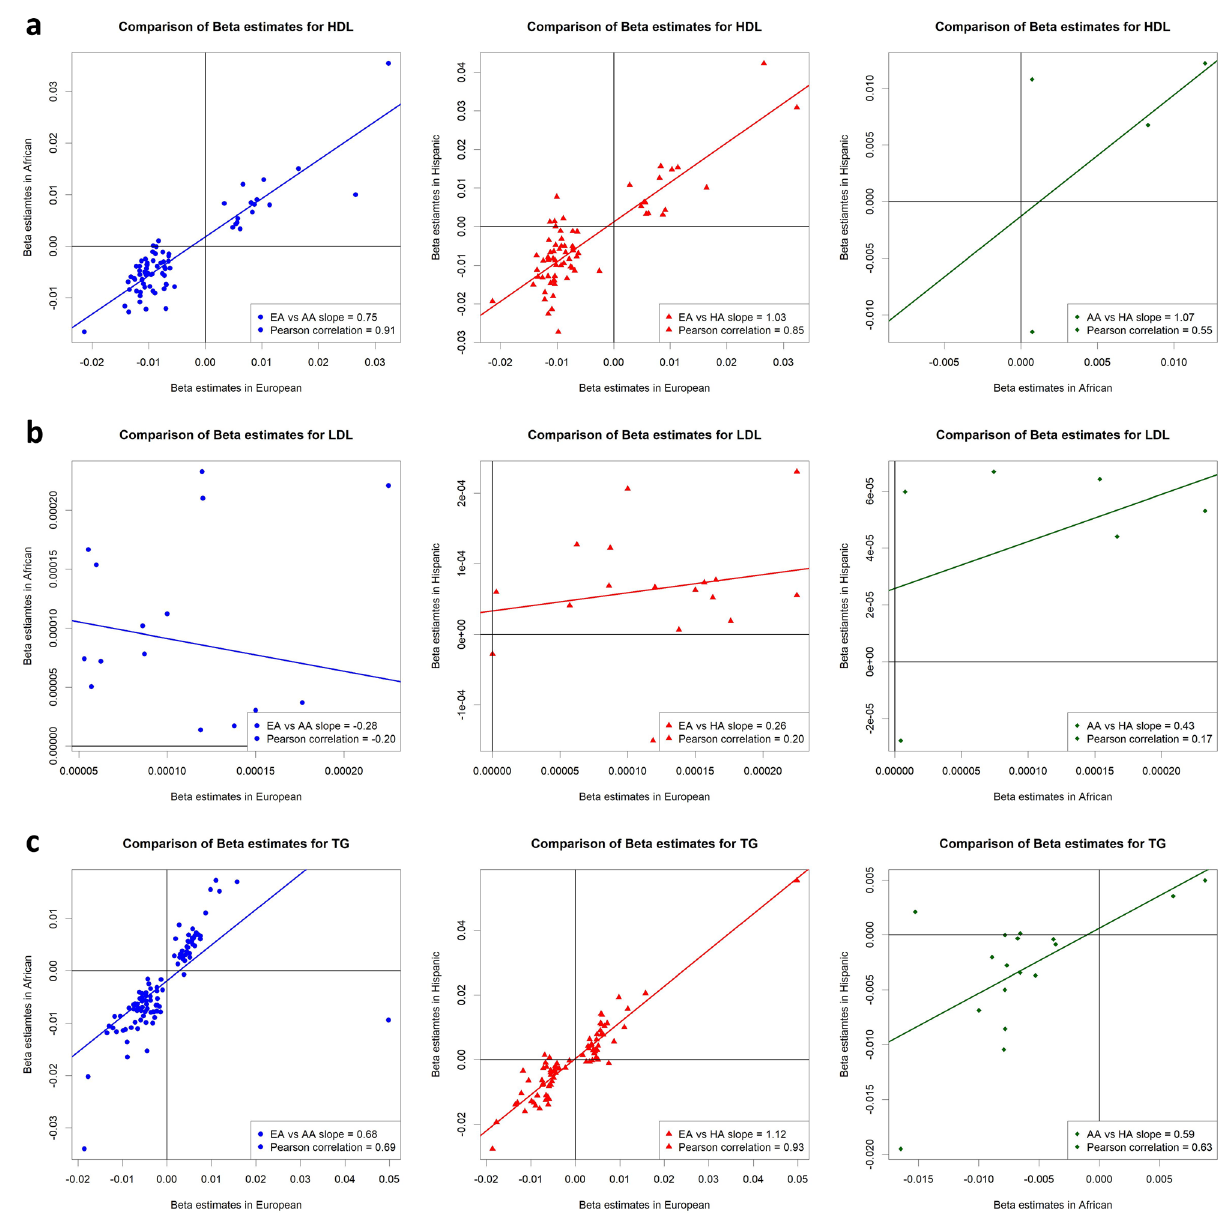
Fig. 2 Scatter plots and regression lines of beta estimate pairs observed in two racial/ethnic groups for CpG-lipid trait associations. Plotted are betas from CpGs found to be signi fi cant ( P < 1.09 × 10 − 7 ) in one or more racial/ethnic group. Plots and lines are shown between Europeans (EA) and African Americans (AA) (blue arrowheads/lines), Europeans (EA) and Hispanics (HA) (red triangles/lines), and African Americans (AA) and Hispanics (HA) (green diamonds/lines) for ( a ) high-density lipoprotein (HDL), ( b ) low-density lipoprotein (LDL), and ( c ) triglycerides (TG). Numerical regression slope and Pearson correlation coef fi cients are presented in the bottom right corner of each